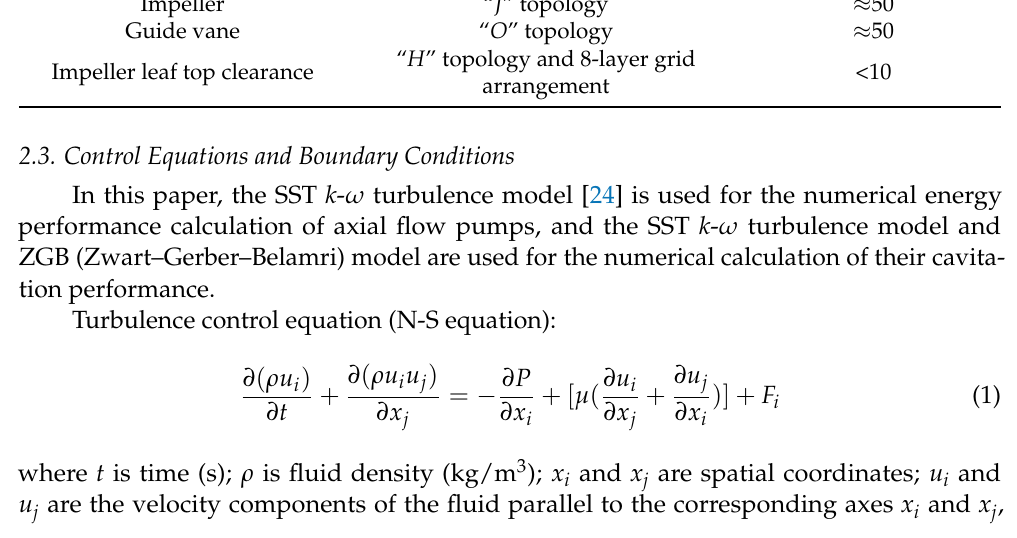
Figure 2. Overall structured grid.